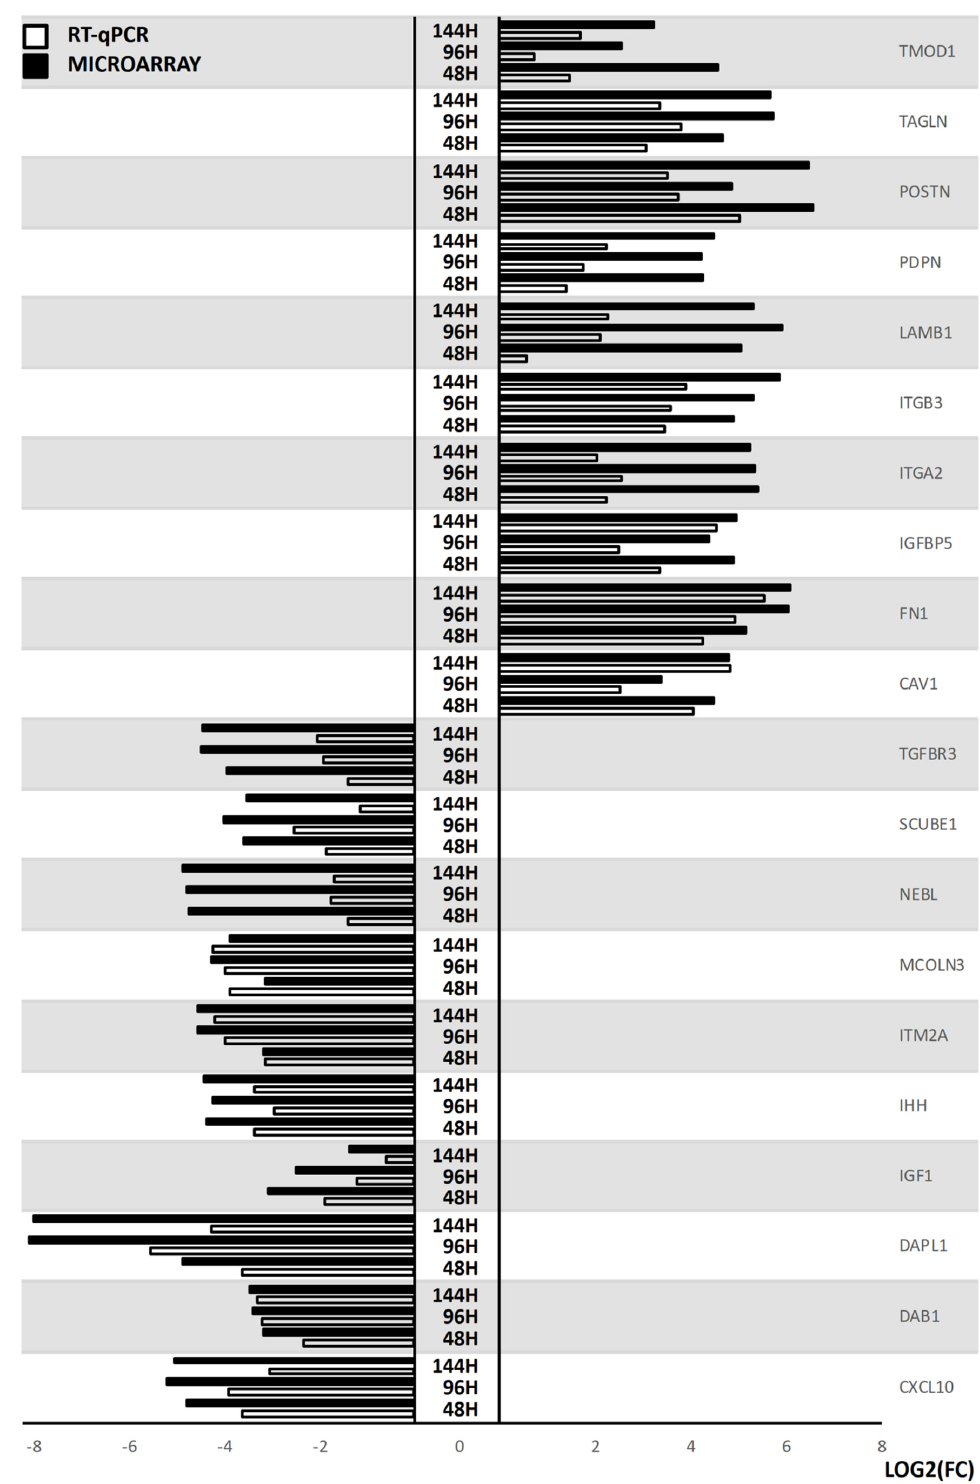
Figure 8. The results of RT-qPCR validation of the analysed genes, presented in the form of bar graph. All of the changes in expression were deemed significant at p < 0.05 after adjustment for multiple comparisons.